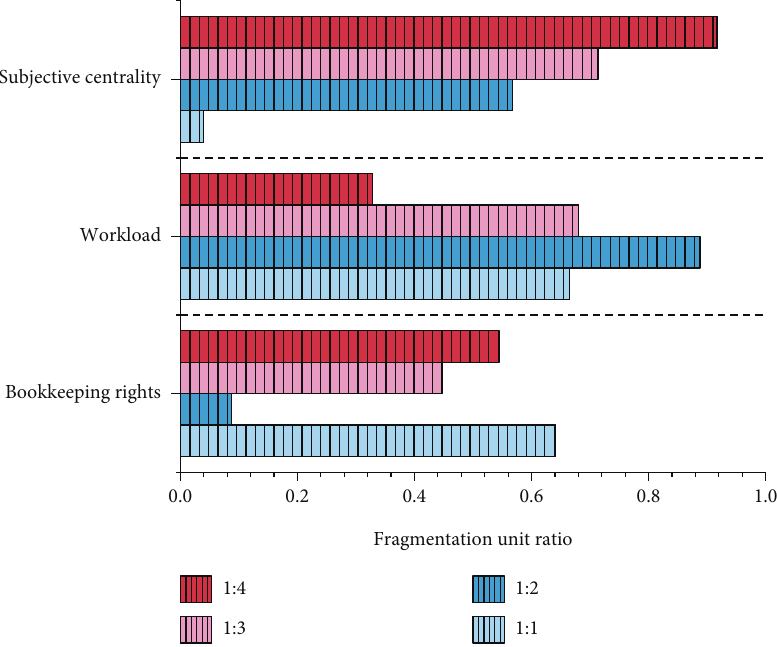
Figure 5: Variation characteristics of discrete element parameters of smart